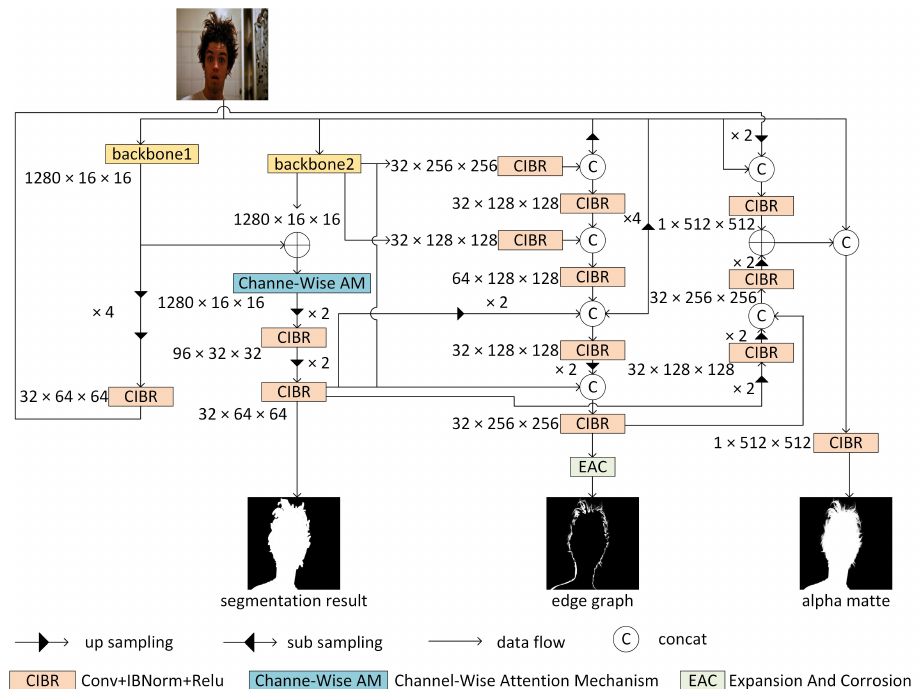
Figure 2. A diagram of a static teacher network as the complex